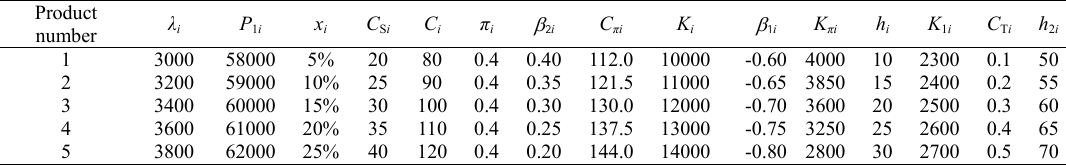
Table 1. Values of system parameters used in the section of numerical example